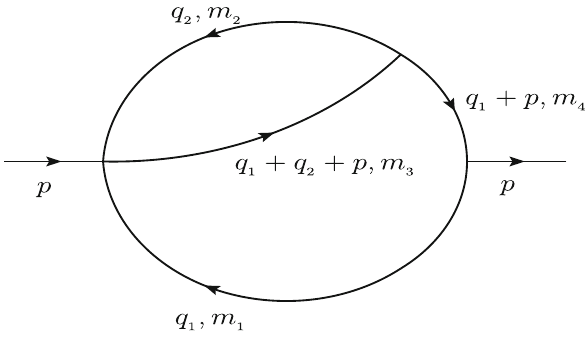
Fig. 1 The 2-loop self energy with 4